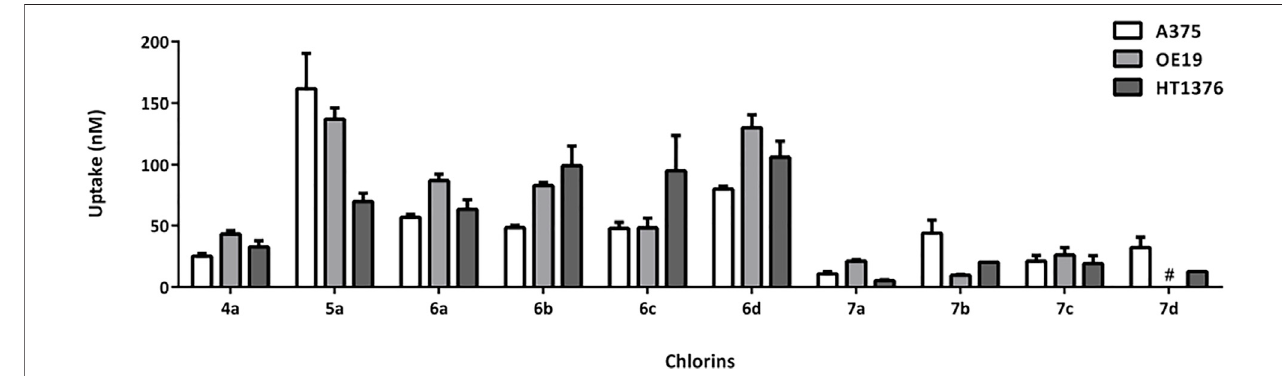
FIGURE5| Uptakevaluesofchlorins 4a , 5a , 6 ,and 7 byhumanA375skinmalignantmelanoma,OE19esophagealadenocarcinoma,andHT1376urinarybladder carcinoma cells. Cells were incubated with the chlorins in a concentration of 500 nM for 24 h. Results are presented as mean ±SE.